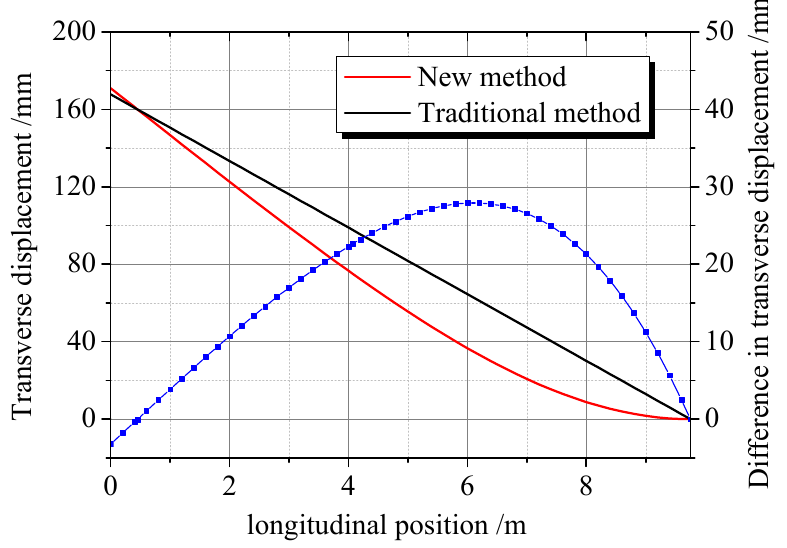
Figure 6. Difference in transverse displacement curves of switch rail under separated state.